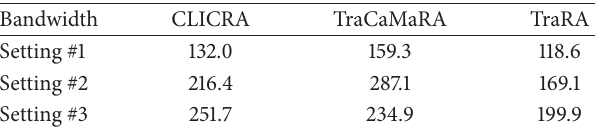
Table 5: Transmitted bytes (Gbytes) from the origin server to the proxy